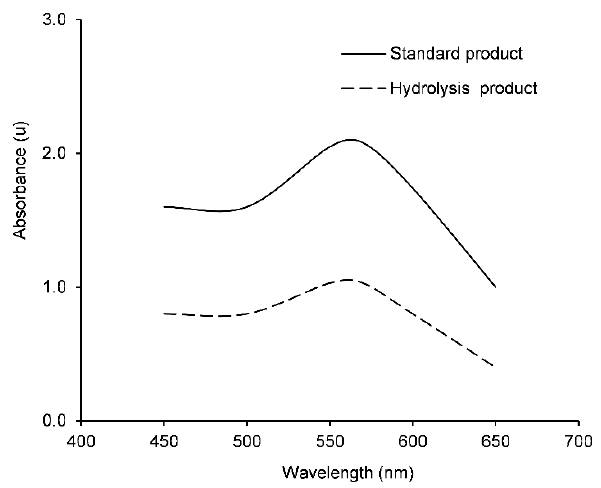
Figure 1. Absorbance spectrum of reaction products ( α -naphthol + Fast Garnet). Alpha-naphthol was obtained from the standard product (1 mM) or enzyme source via hydrolysis of α -naphthyl acetate (1 mM). Absorbance measurements were conducted in a continuous reading spectrometer with a 1-cm light path cuvette ( n = 3).